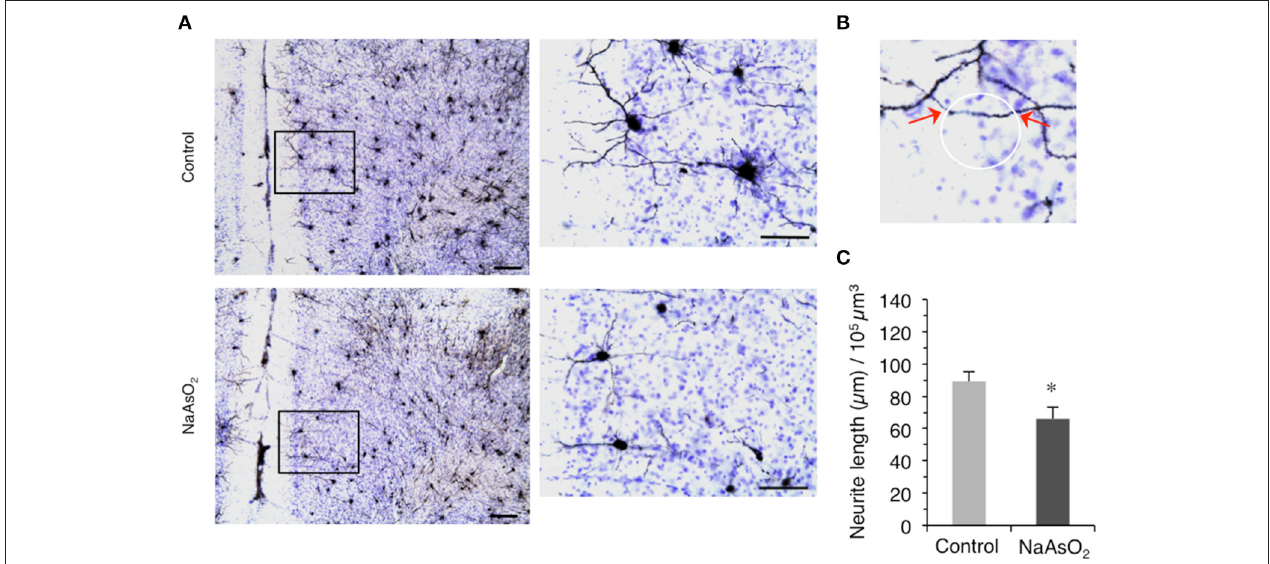
FIGURE 3 | Altered morphology of neurites in the PrL of adult female mice born to dams that were administered NaAsO 2 during gestation. (A) Representative photomicrographs of the PrL in Golgi- and Cresyl Fast Violet-stained coronal brain sections from female mice with or without prenatal exposure to NaAsO 2 . The rectangular area was magnified and shown in the corresponding right panel. Bars = 20 µ m (low magnification) and 10 µ m (high magnification). (B) Demonstrative photomicrograph for the intersection points (indicated by red arrows) between a virtual sphere “Space Ball” (white circle) and Gogli-stained neurite. (C) Estimated neurite lengths in Golgi-stained PrL neurons as measured by the Space Ball method. Values (mean ± SEM) were normalized to the estimated volume of the selected PrL region (control group n = 7, NaAsO 2 -exposed group n = 5). An asterisk indicates p < 0.05 vs. the control